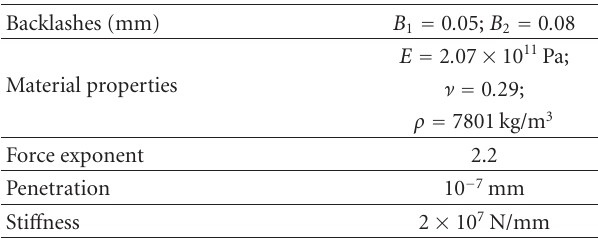
Table 2: Simulation parameters.